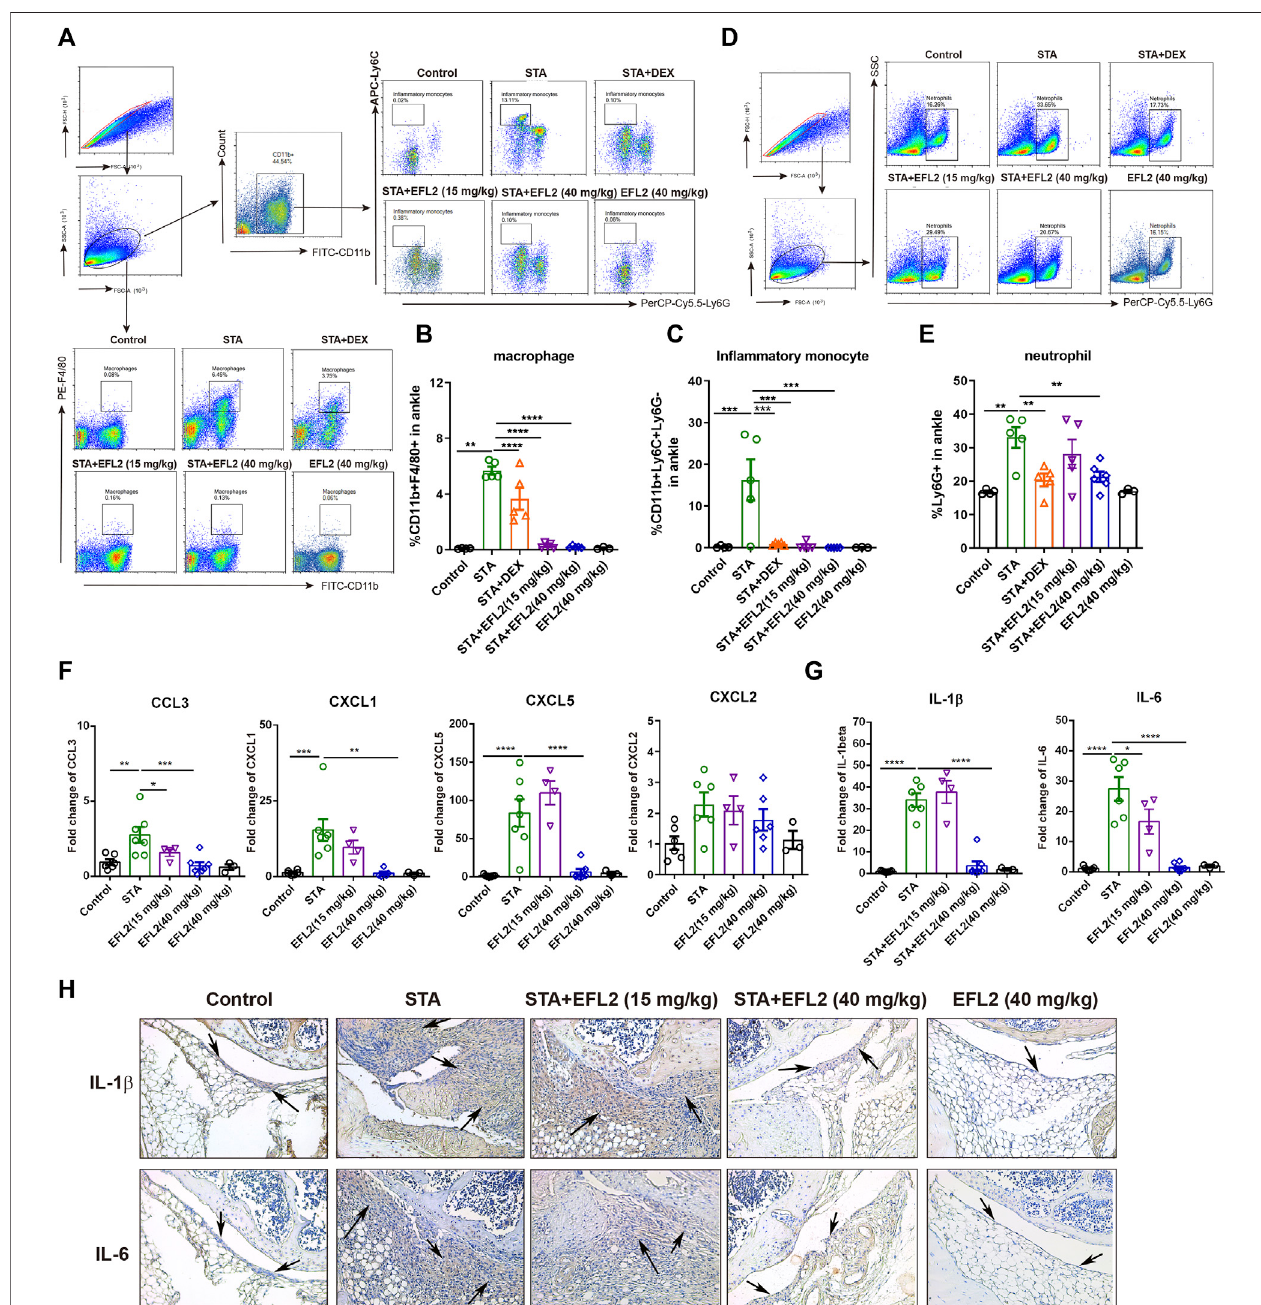
FIGURE 2 | Euphorbia factor L2 suppresses in fl ammatory cells in fi ltration into the ankle. Flow cytometry gating strategy and quanti fi cation for macrophages (CD11b + F4/80 + ) (A, B) , in fl ammatory monocytes (CD11b + Ly6C + Ly6G − ) (A, C) and neutrophils (Ly6G + ) (D, E) in the ankles from the control, STA, STA mice treated with DEX or EFL2 (15 or 40 mg/kg) and mice solely treated with EFL2 (40 mg/kg) (n (cid:1) 3-7 per group) (G, H) mRNA expressions of chemokine CCL3, CXCL-1, CXCL-5, CXCL2 (G) and in fl ammatory cytokine IL-1 β and IL-6 (H) in the ankles from each group (I) Immunohistochemical staining for IL-1 β and IL-6 in the ankle from the control, STA, STA mice treated with EFL2 (15 or 40 mg/kg) and mice solely treated with EFL2 (40 mg/kg). Arrows represent the synovium with numbers of in fi ltrated in fl ammatory cells. Data represent the mean values ± SEM. * p < 0.05, ** p < 0.01, *** p < 0.001, **** p < 0.0001 were considered as signi fi cant.